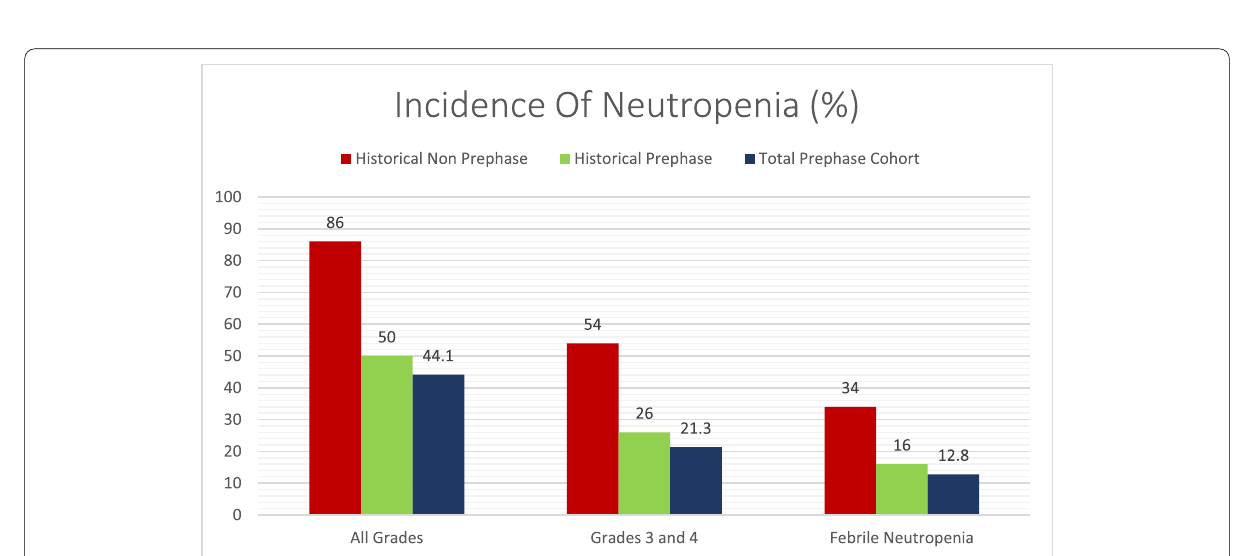
Fig. 2 Incidence of neutropenia on day 10 of 1st cycle chemotherapy. In comparison to historical cohort of patients